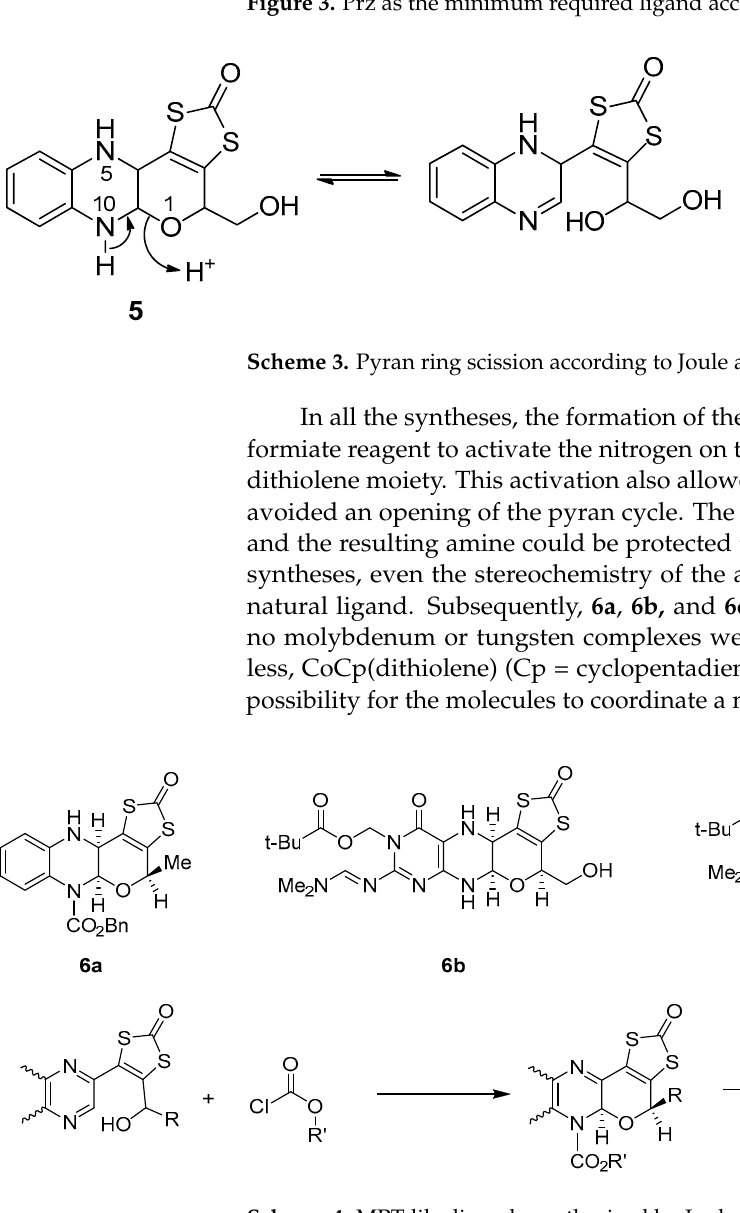
Figure 3. Prz as the minimum required ligand according to the DFT calculations.